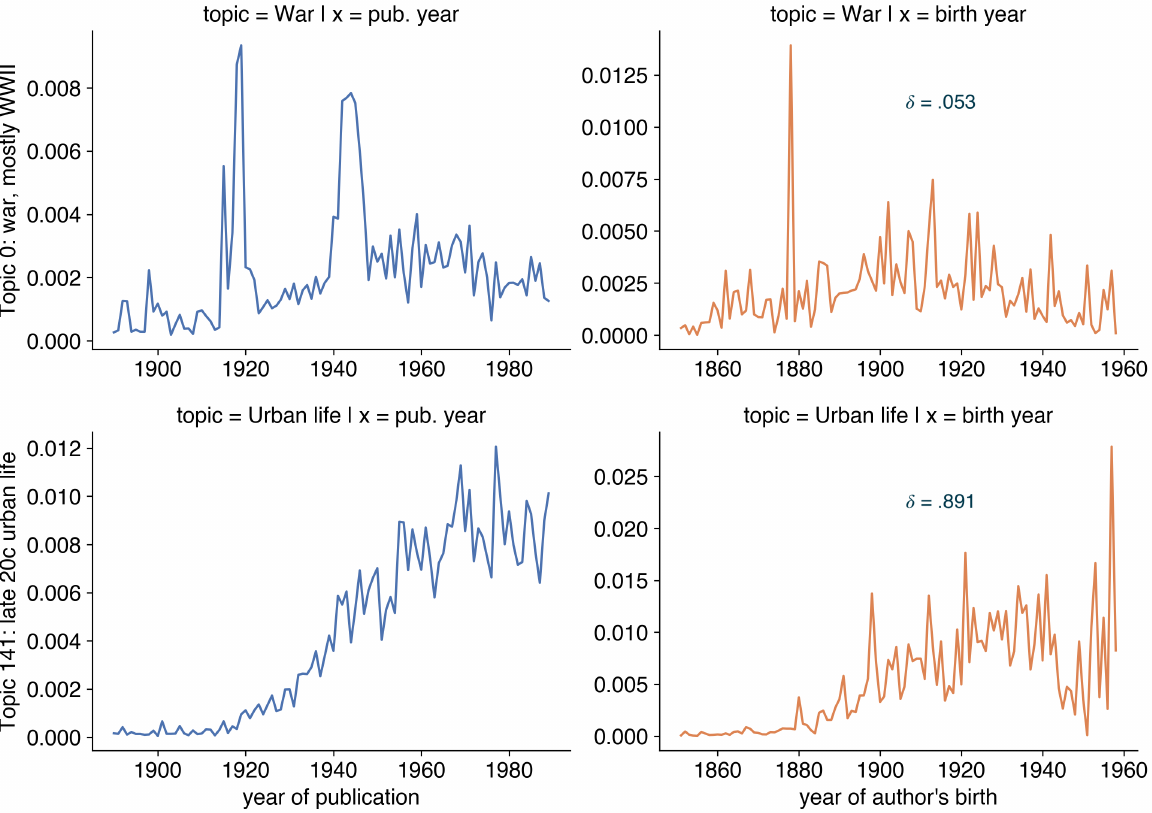
Figure 2: The yearly frequencies of two topics with markedly different delta values; n = 29, 351. Delta will be low when changes unique to the left-hand column are both large and durable for out-of-sample authors; it will be high when the same is true on the